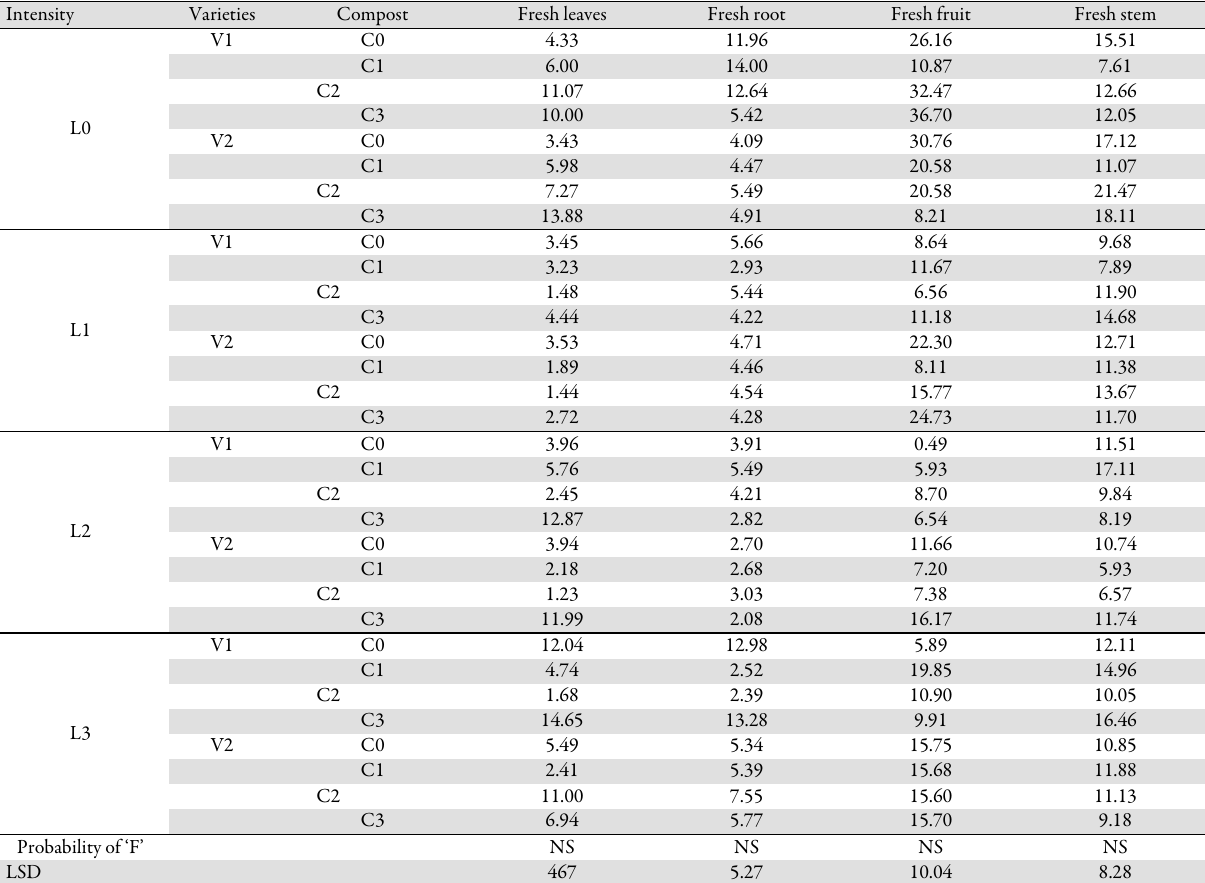
Table 5. Interactive effect of compost application on the fresh weight of two cultivars of okra in the pot experiments Intensity Varieties Compost Fresh leaves Fresh root